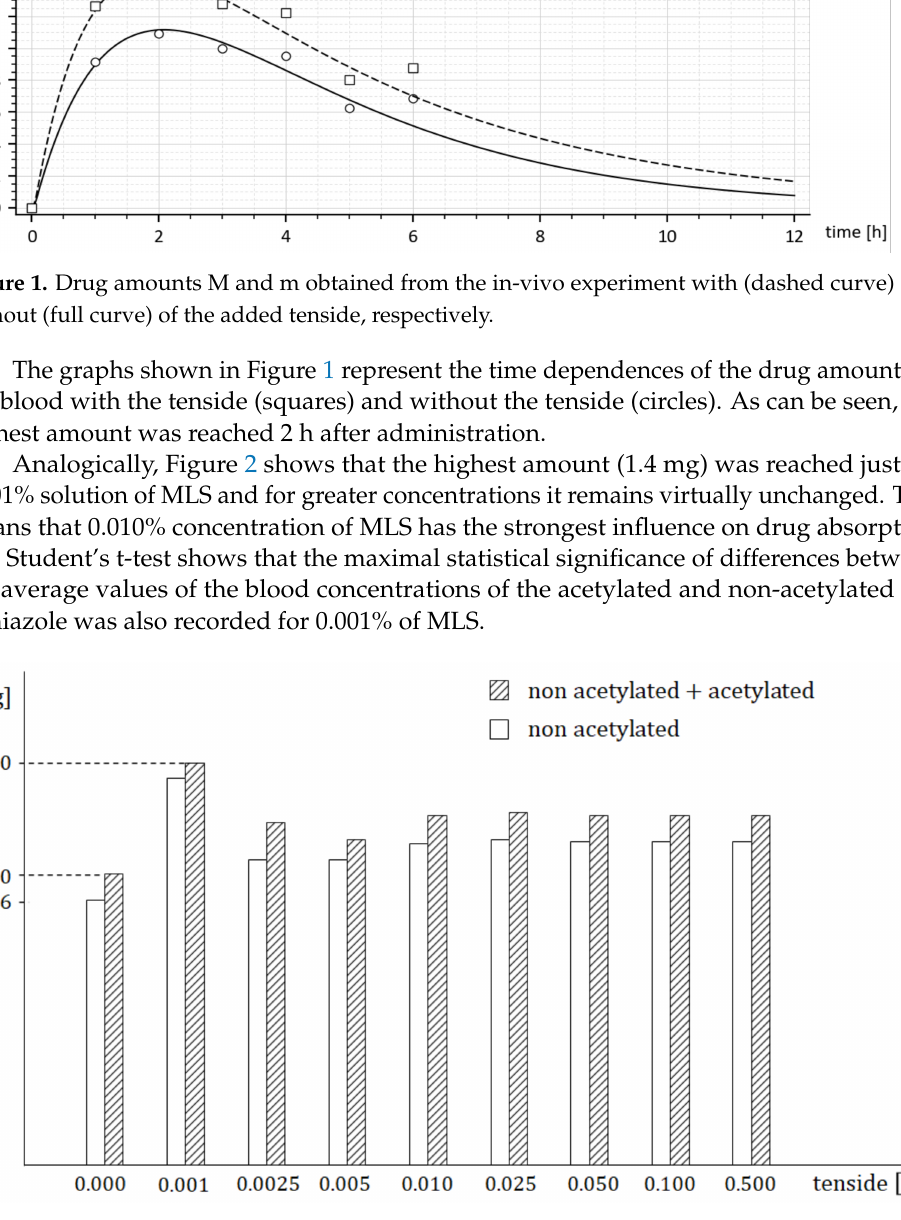
Figure 2. Influence of various concentrations of tenside on the drug amount in the blood. Both acetylated and non-acetylated forms of the drug were evaluated. It was found that approximately 8% of the dose